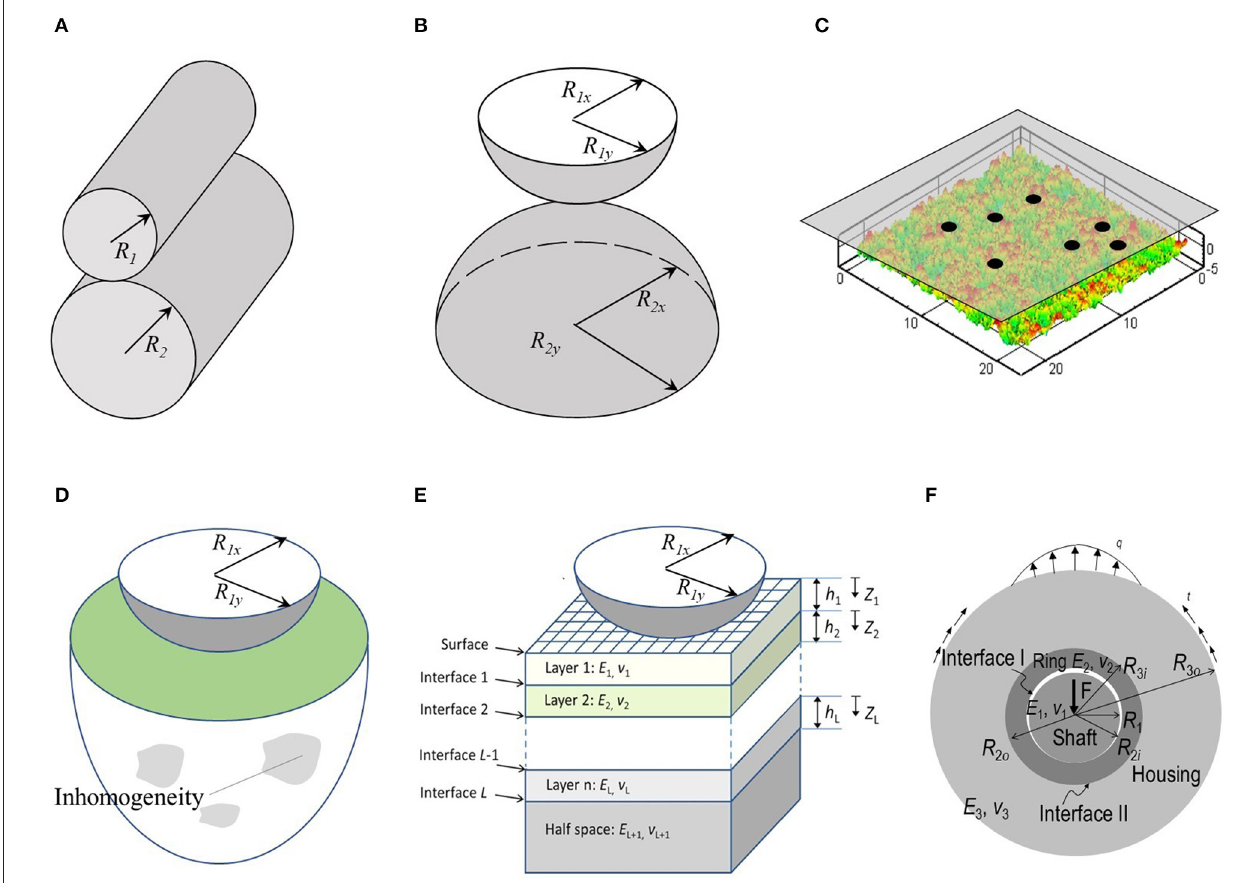
FIGURE 2 | Different types of contact problems solved by using a FFT-based method. (A) Line contact, (B) point contact, (C) nominally flat-flat contact, (D) contact involving an inhomogeneous material, (E) contact involving a layered material or other anisotropic materials, and (F) conformal contact of 2D journal bearings or rollers. Note that all surfaces can be smooth or